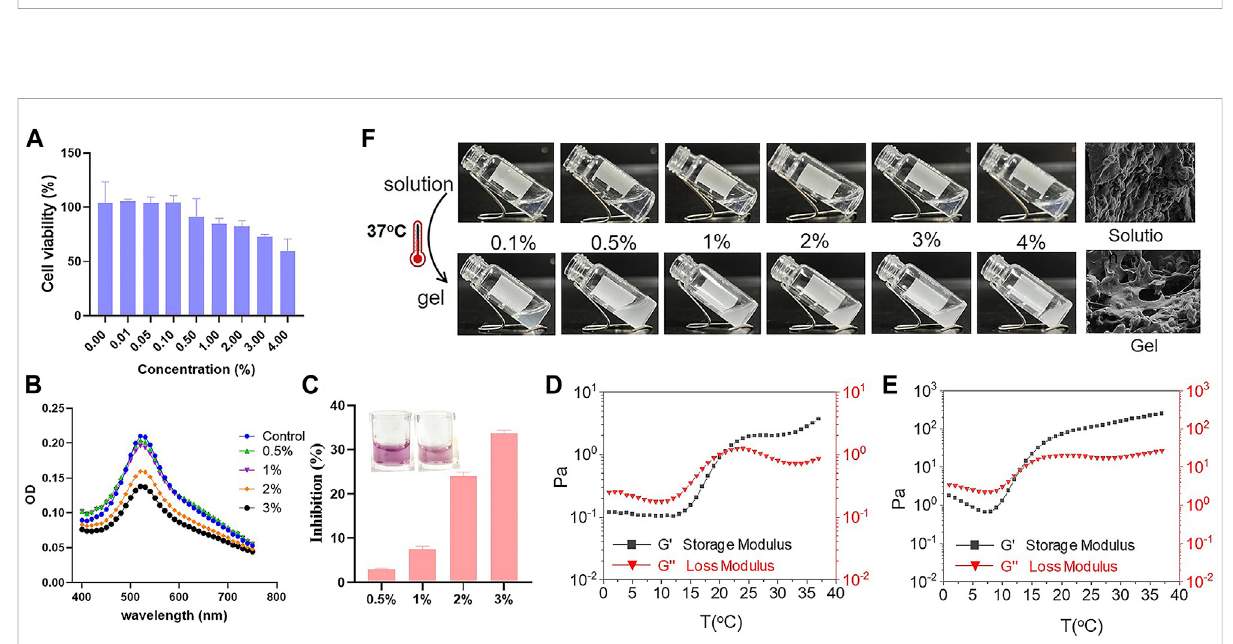
FIGURE 1 SynthesisandcharacterizationofSe-PEG-PPG. (A) SynthesispathwayofSe-PEG-PPG; (B) 1 HNMRspectrumofSe-PEG-PPGwithdetailed peak distribution; (C) FT-IR spectrum of Se-PEG-PPG.